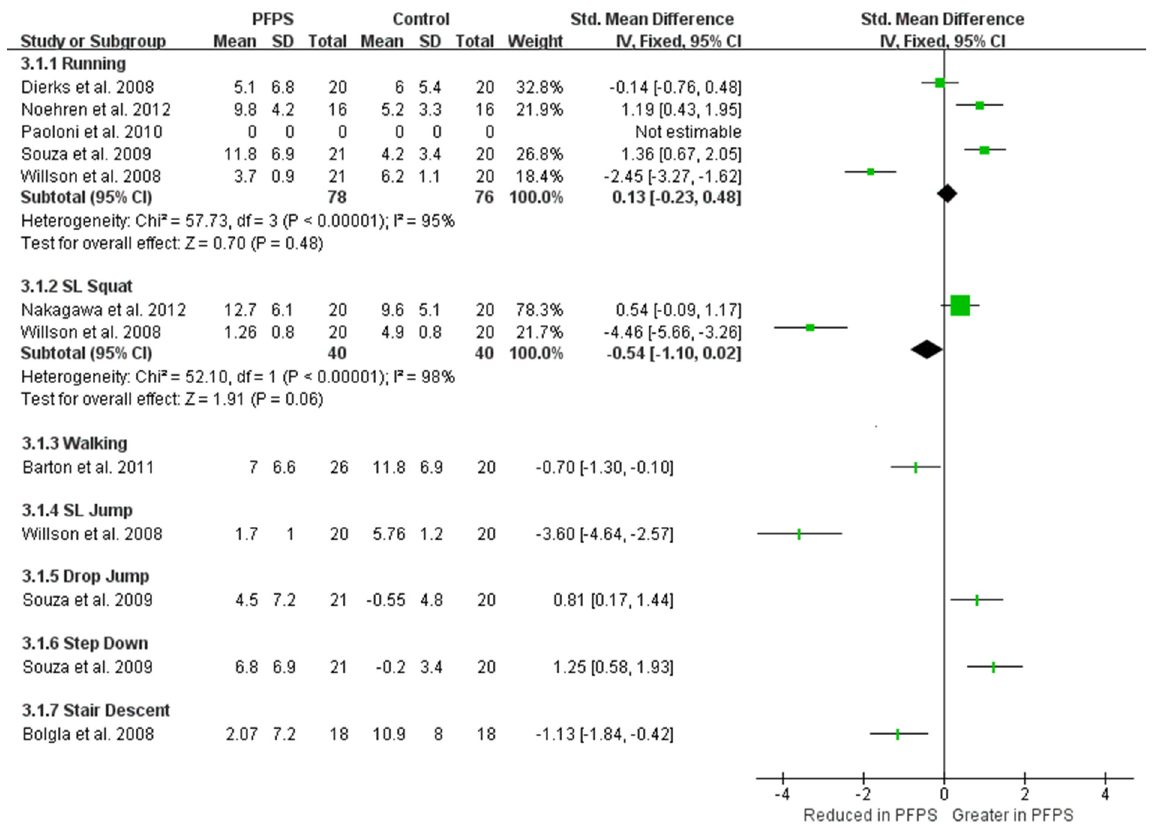
Figure 4. Hip internal rotation angle between PFPS and control group among the various functional